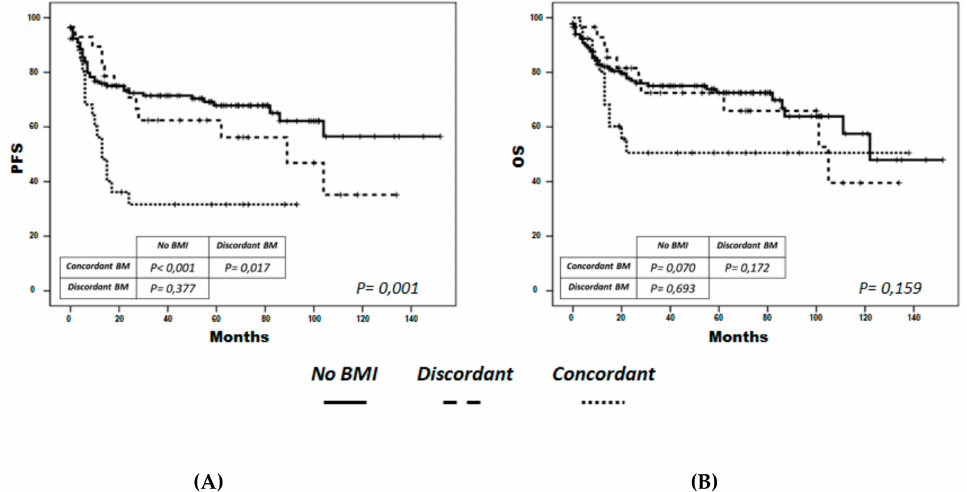
Figure 1. Progression-free survival (PFS) ( A ) and overall survival (OS) ( B ) by bone-marrow infiltration type. PFS and OS were significantly lower ( p < 0.001 and p = 0.08, respectively) in patients with concordant infiltration (dotted line), than in those without BM infiltration (continuous line) and with discordant infiltration (discontinuous line). No significant di ff erences were observed between the latter two groups (p >